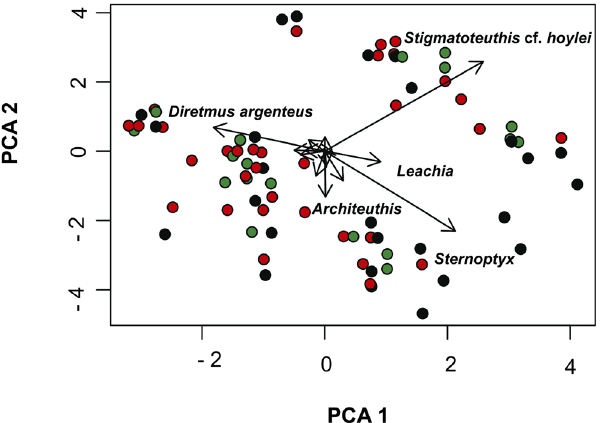
Figure 2. PCA scaling plot of 126 samples (after excluding rare occurrences < 5%). Distances among sample points correspond to differences in species composition. Samples colored green, red and black were collected during full-, new- and quarter- moon, respectively. Total variance of PC1 = 28.12 and PC2 = 23.38 are shown on the respective axes. The magnitude of species vectors are shown on the PCA and are proportional to the variation represented by the principal components (PC1 and PC2). Only the most influential species (with eigenvalues > 0.25) contributing to the co-variance of the PCA are labeled on the